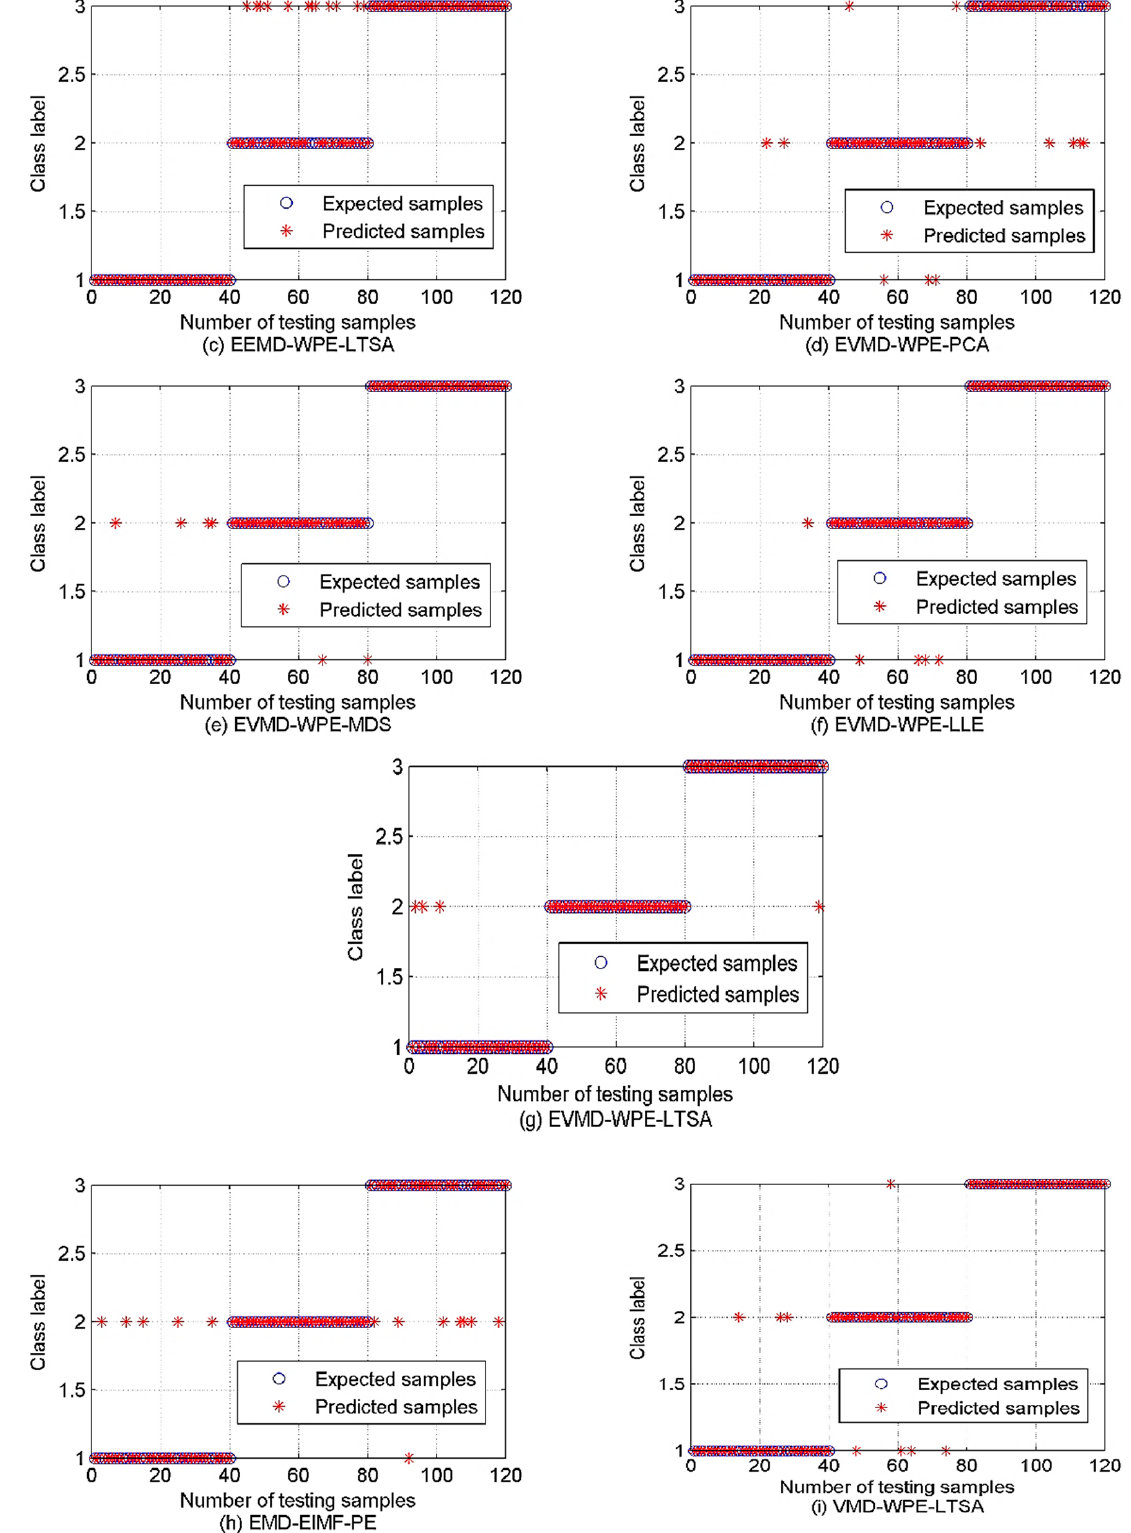
Figure 18. The outputs of classification under different algorithms. ( a ) WPE; ( b ) EMD-WPE-LTSA; ( c ) EEMD-WPE-LTSA; ( d ) EVMD-WPE-PCA; ( e ) EVMD-WPE-MDS; ( f ) EVMD-WPE-LLE; ( g ) EVMD-WPE-LTSA; ( h ) EMD-EIMF-PE; ( i ) VMD-WPE-LTSA.